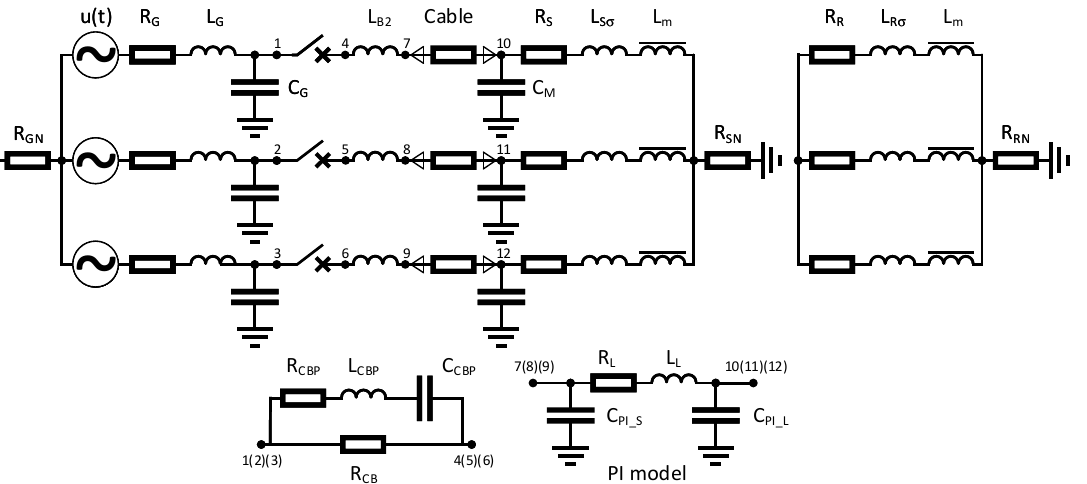
Figure 3. Circuit diagram of induction motor. Numbers refer to the interconnection points among components drawings in Figure.